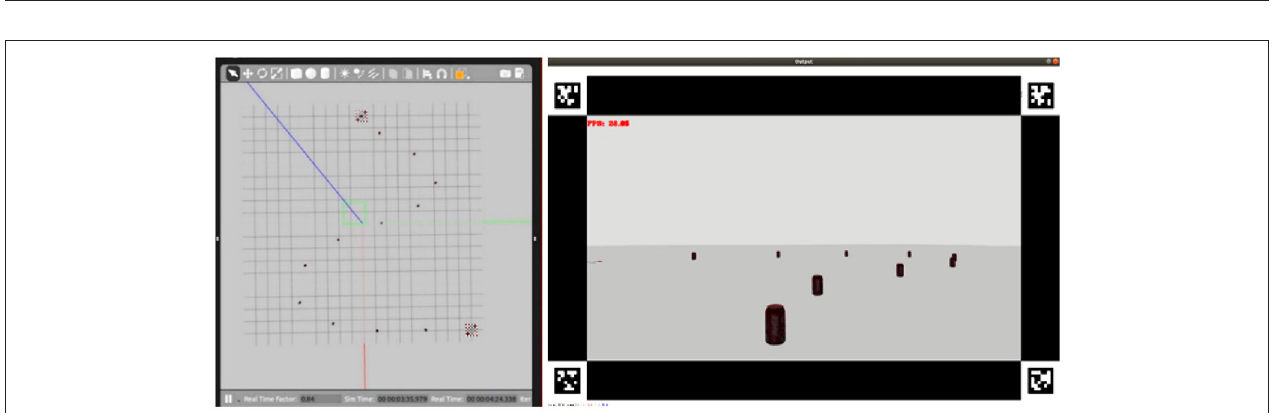
FIGURE 8 | Accuracy task. Left : top view of the simulated environment used in the test allowing the experimenters to visualize the whole set-up off-line. Right : first-person view seen by the user.